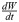
BBR profile reflecting key equilibria in relation to population parasite burden.The BBR profile for the PDD (a, solid line) and PDD-free (a, dashed line) models. Note the symmetry with the Reff profile shown in Fig 1, including the location of key equilibria at the breakpoint (Wbp) and endemic equilibrium (Weq) where Reff and BBR = 0. Also shown is the rate of change of worm burden, dWdt (b), across log-transformed worm burden, W, for the PDD (solid line) and PDD-free (dashed line) models. At low values of W (b, inset), the models diverge as transmission in the PDD model (solid lines) is restricted by reduced mating probability leading to dWdt < 0 below the breakpoint, Wbp.